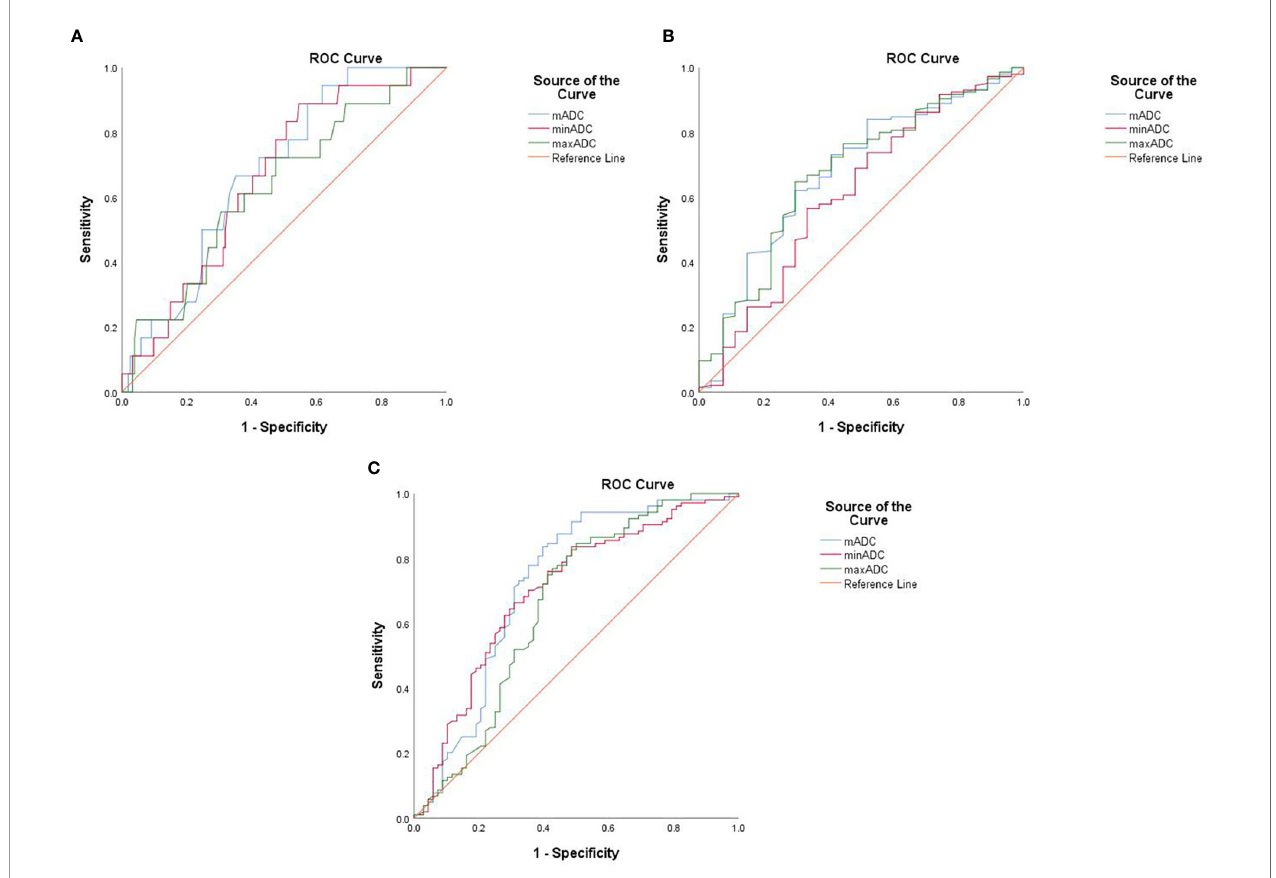
FIGURE 3 | The ROC curves of mADC, minADC and maxADC values of different groups: (A) Groups A and B, (B) Groups C and D, and (C) Groups E and F We de fi ned G1 endometrioid carcinoma con fi ned to the endometrium as Group A, and the others were de fi ned as Group B Group C included endometrioid carcinoma, whereas nonendometrioid carcinoma was de fi ned as Group D Stage IA G1/2 endometrioid carcinoma was included in Group E, and the remaining patients were included in Group